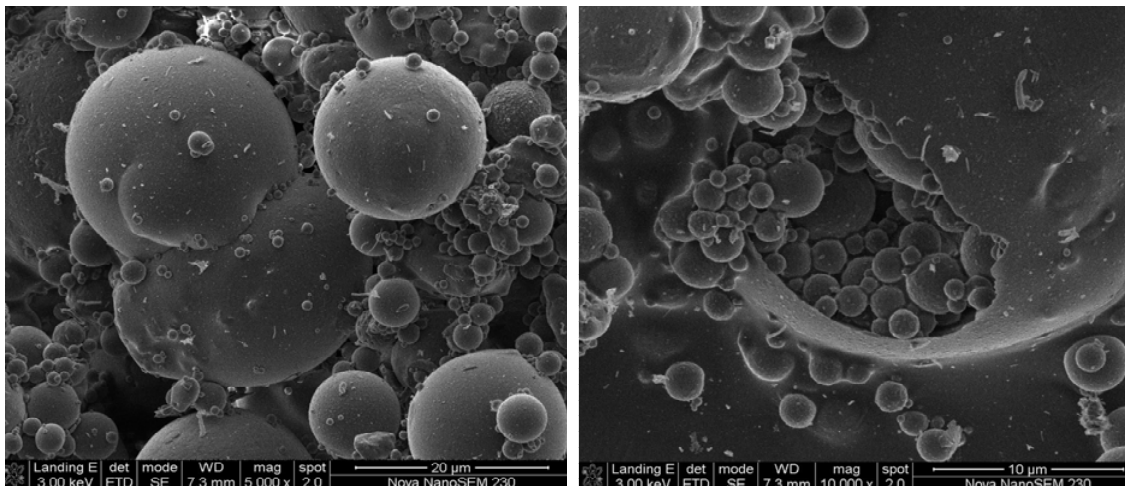
Figure 2. SEM images of fly ash